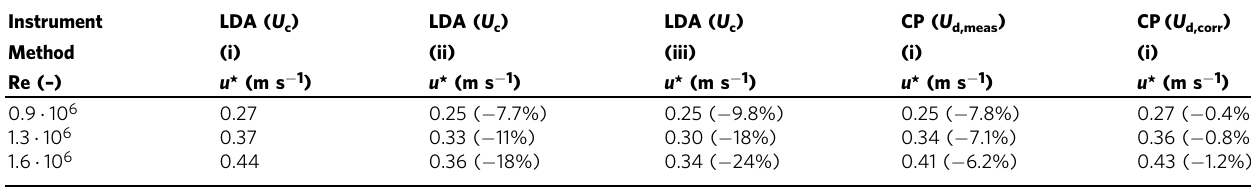
Table 1 Estimations of u * with different methods and instruments for different fl ow conditions (rounded to two decimals). Instrument